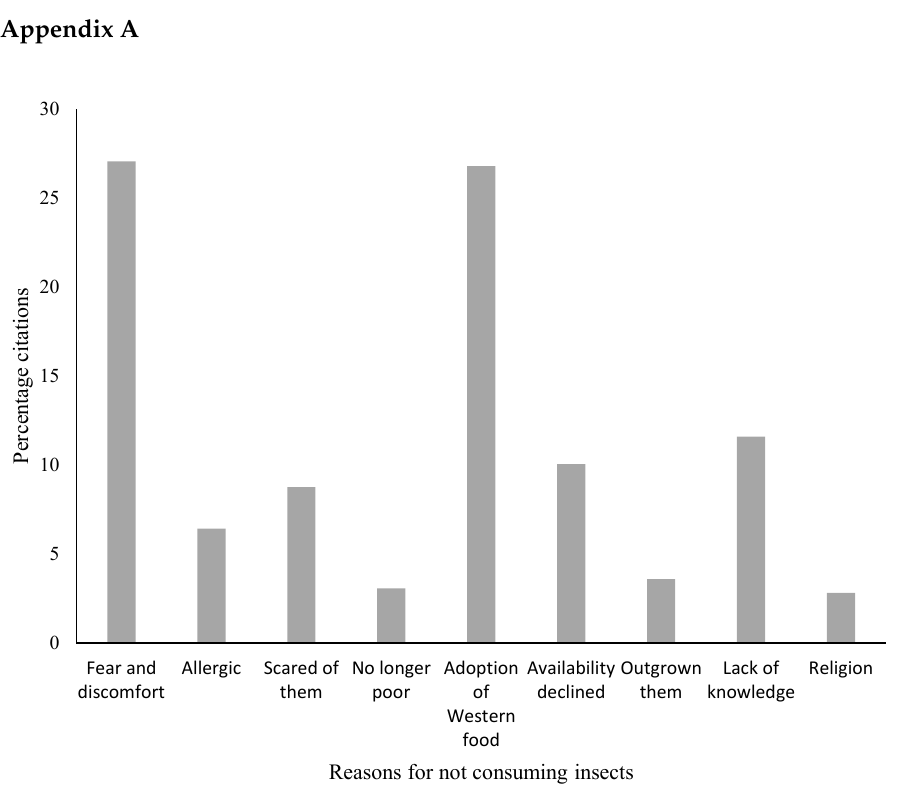
Figure A1. Cited reasons for not consuming insects in KwaZulu-Natal province ( n = 356).